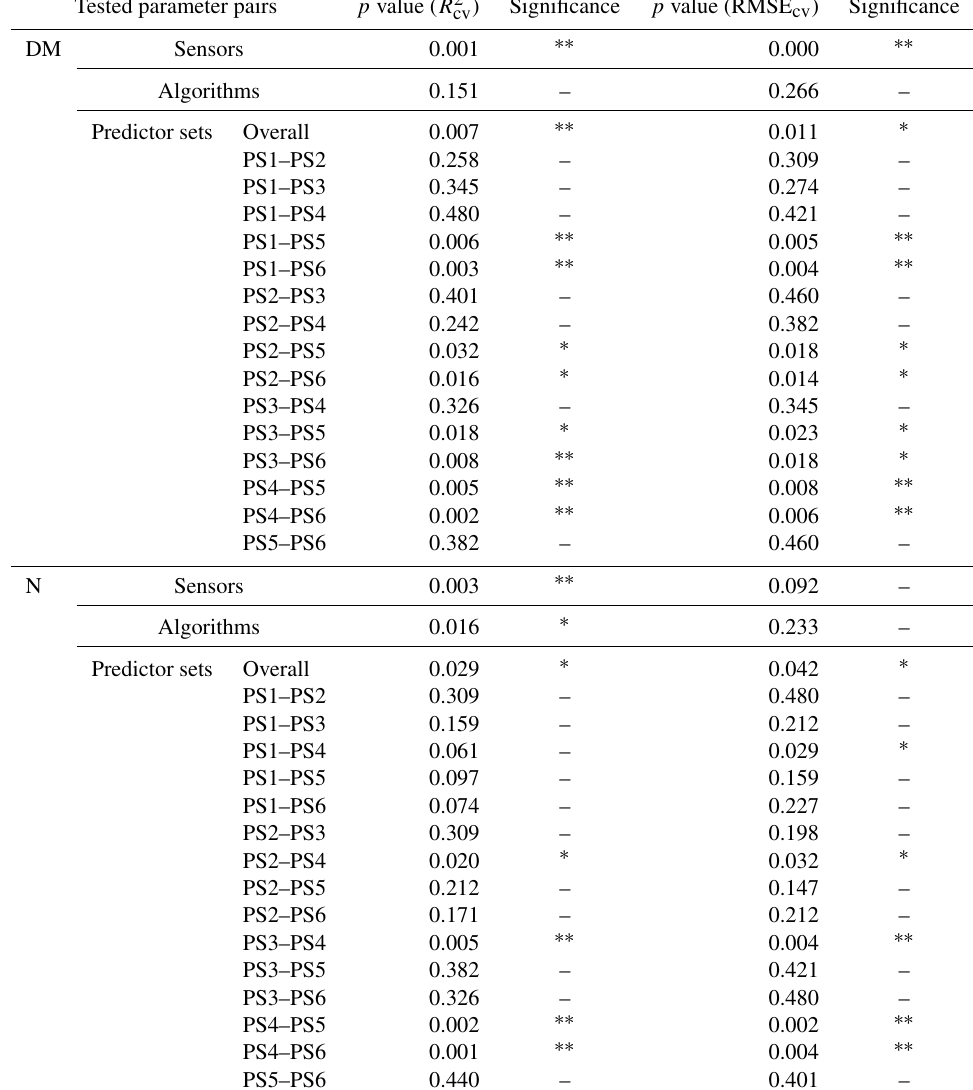
Table A1. Results of the non-parametric statistical tests between parameter pairs on R 2 cv and RMSE cv . Three different tests were carried out: Wilcoxon test for sensors and algorithms ( N treat = 2), Kruskal–Wallis test for predictor sets overall, and Dunn’s test between predictor sets (see details in Sect. 2.3.5). Note that all the tests were done for paired samples.